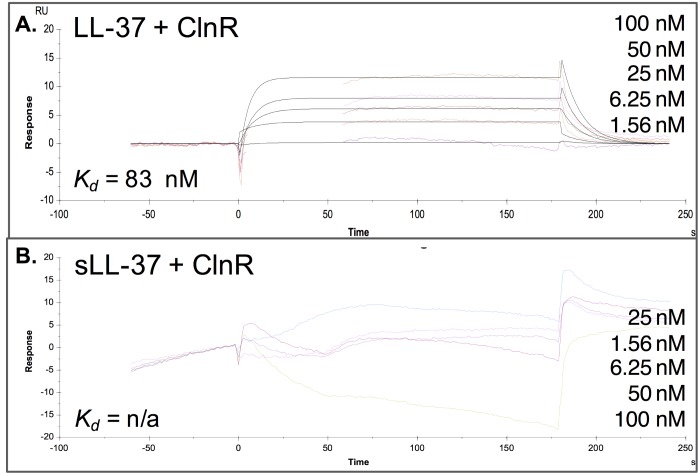
ClnR binds specifically to LL-37.Kinetic analysis of ClnR-LL-37 binding. Surface Plasmon Resonance (SPR) sensorgram quantifying binding of His-ClnR to immobilized A) LL-37 or B) scrambled LL-37 (sLL-37; negative control) measured as the relative response in resonance units (RU) after reference background subtraction. The concentrations of His-ClnR applied are listed in their order on the graphs, respectively. Affinity modeling (1:1) was used to calculate the dissociation constant for binding. LL-37-ClnR: Kd = 83 ± 14 nM; sLL-37-ClnR: no significant binding detected.